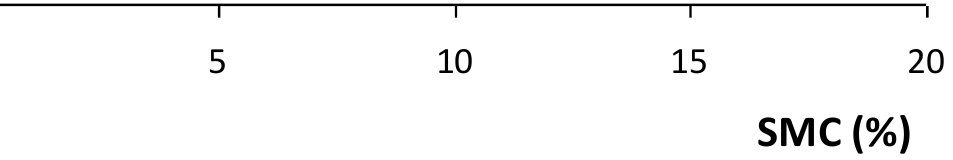
Figure 14. Relationship between mean soil moisture content (SMC) and mean Cone Index (CI) in the 0 – 0.30 m soil layer (2021/2022).